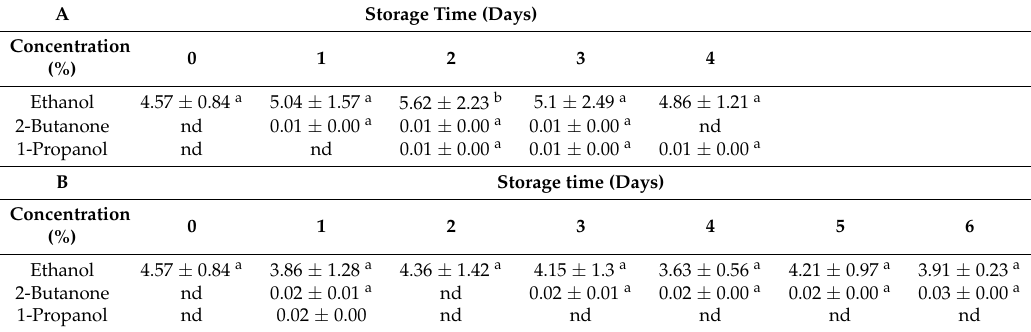
Table 3. The evolution of volatile compounds detected in tchapalo stored at ( A ) ambient temperature (28 to 30 ◦ C) for four days and ( B ) 4 ◦ C for six